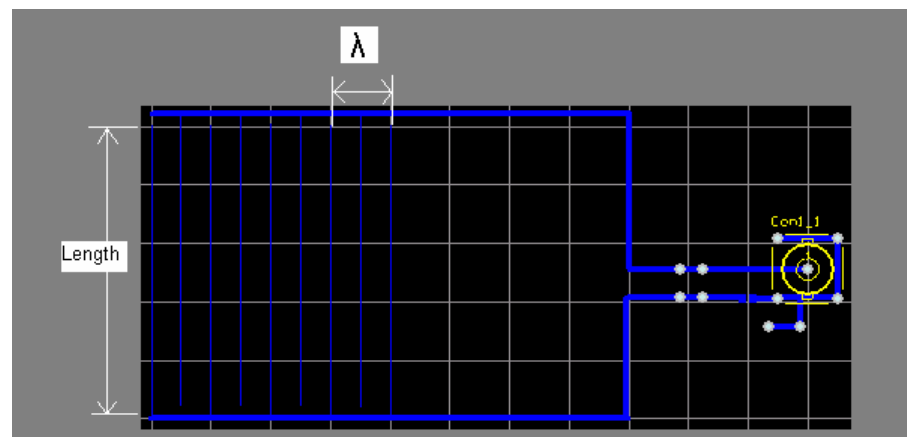
Figure 8. Schematic diagram of interdigital type sensor.